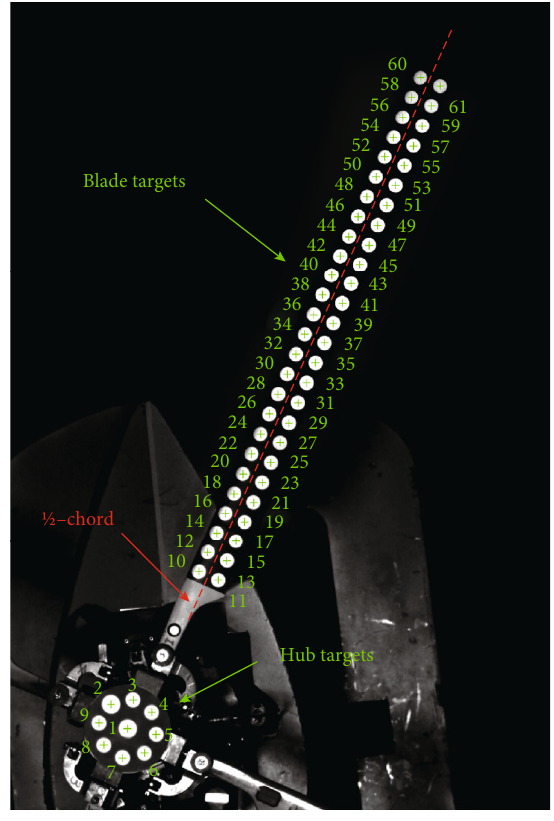
Figure 12: Numbering de fi nition of all targets on the rotor.